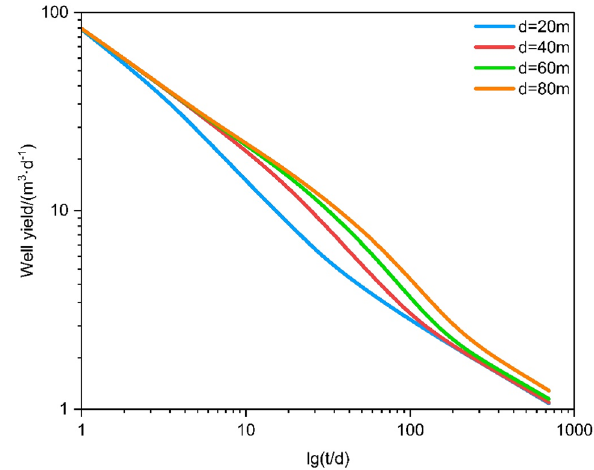
Fig. 11 Well production curves with different hydraulic fracture spac-